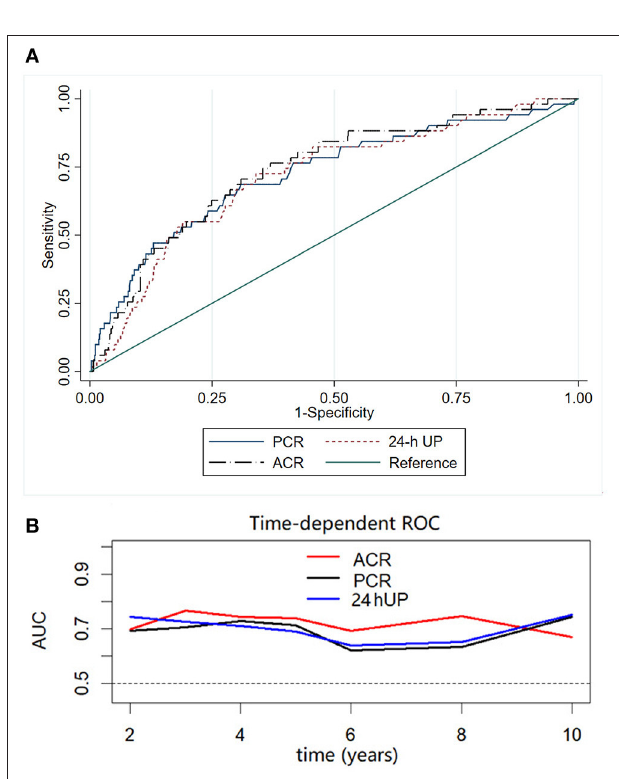
FIGURE 3 | Receiver operating characteristic (ROC) (A) and time-dependent ROC (B) curves with the composite outcome as the status variable. The AUCs were compared among ACR, PCR, and 24-h UP using ROC and time-dependent ROC curves. Among these indicators, ACR had the highest